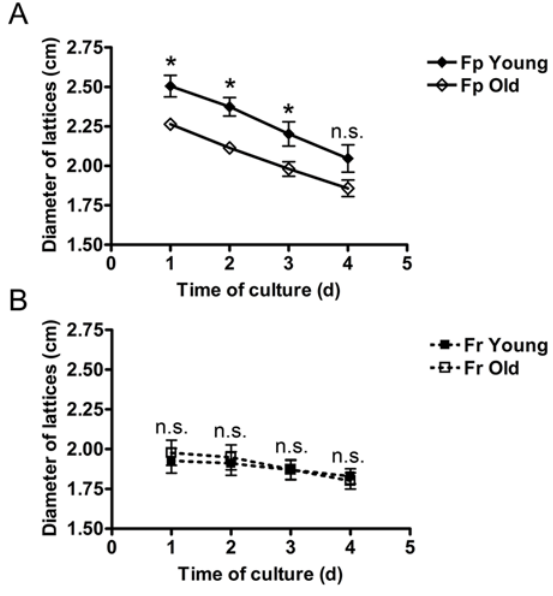
Figure 7. Age-dependent capacity of Fp and Fr to contract a collagen gel. Dermal equivalents were generated with Fp and Fr samples from 3 young (19 yr, 21 yr, and 26 yr) and 3 old donors (57 yr, 62 yr, and 74 yr). Diameter of lattices (cm) was measured at days 1, 2, 3, and 4. (A) Evolution of the diameter of lattices generated with Fp from young and old donors (means 6 SEM, n=3, independent samples). (B) Evolution of the diameter of lattices generated with Fr from young and old donors (means 6 SEM, n=3). (*p , 0.05; n.s.=not significant). promote epidermal morphogenesis and full differentiation, as compared to the other fibroblast populations tested (Fig. 8I to 8L).